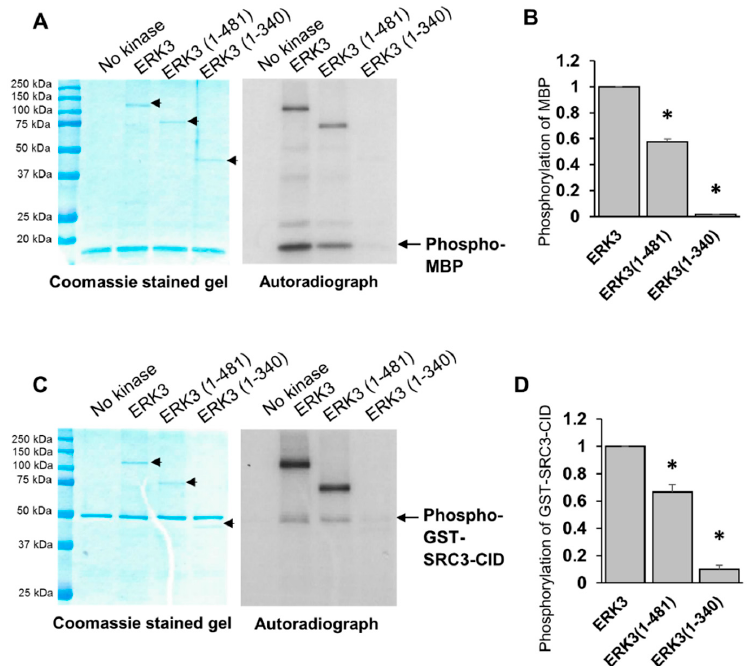
Figure 3. Truncation of the C-terminus extension decreases the in vitro kinase activity of ERK3 towards myelin basic protein (MBP) and steroid receptor co-activator 3 (SRC-3) substrates. ( A ) In vitro kinase assay for full length or deletion mutant ERK3 proteins purified from mammalian 293T cells using MBP as a substrate. The assay was performed by incubating 40 nM of each ERK3 protein with 1 µ g of recombinant MBP in kinase assay bu ff er containing ( γ - 32 P)-ATP. The reaction products were analyzed by SDS-PAGE and autoradiography. Total level of MBP substrate in each reaction is shown by Coomassie staining (left panel). ERK3 proteins in the Coomassie stained gel are marked with arrowheads. Please note that ERK3 proteins are barely seen in the Coomassie-stained gels due to their small amounts. The substrate phosphorylation was detected by autoradiography and marked with arrow (right panel). ( B ) Quantification of MBP phosphorylation by full length or deletion mutant ERK3 proteins. For the purpose of comparison, the normalized phosphorylation level of MBP by ERK3 was arbitrarily set as 1.0. The bar graph represents the mean ± SE of three independent experiments. * p < 0.001 by one-way ANOVA. ( C ) In vitro kinase assay for full length or deletion mutant ERK3 proteins purified from mammalian 293T cells using glutathione S-transferase (GST)-SRC-3-CBP-interacting domain (CID) as a substrate. The assay was performed by incubating 40 nM of each ERK3 protein with 1 µ g of recombinant GST-SRC-3-CID in kinase assay bu ff er containing ( γ - 32 P)-ATP. Total level of substrate in each reaction is shown by Coomassie staining (left panel) and substrate phosphorylation is detected by autoradiography and marked with arrow (right panel). ERK3 proteins in the Coomassie stained gel are marked with arrowheads. ( D ) Quantification of GST-SRC-3-CID phosphorylation by full length or deletion mutant ERK3 proteins. The normalized phosphorylation level of GST-SRC-3-CID by ERK3 was arbitrarily set as 1.0. The bar graph represents the mean ± SE of three independent experiments. * p < 0.005 by one-way ANOVA.